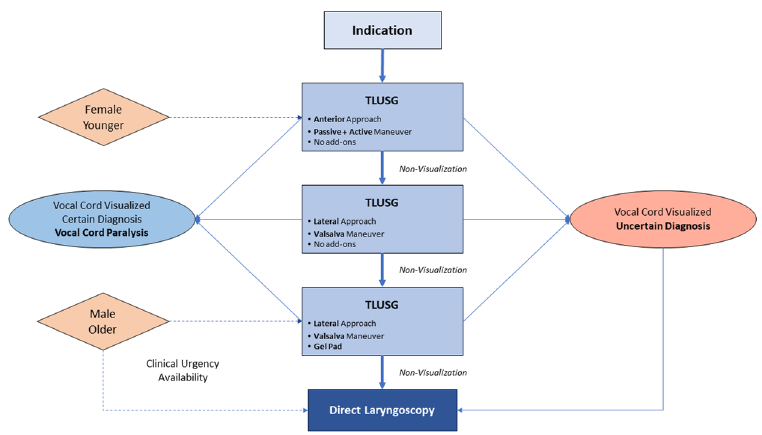
Figure 2. Algorithm to standardize TLUSG examination protocol through ordered use of technical modifications. It also describes considerations for compulsory laryngoscopic examination.